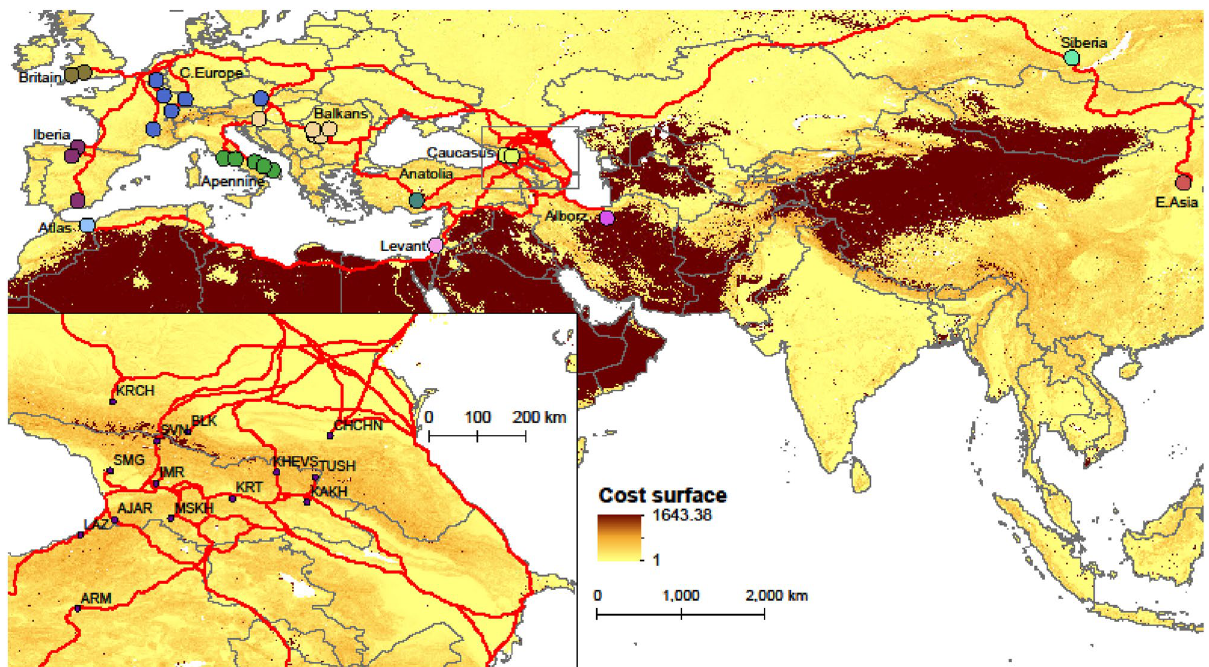
Figure 5. Migration pathways that best explain genetic affinity between modern Caucasians and ancient humans, showing least-cost paths from Eurasian and African ancient populations (shown in the main map, see Table 2 for details) to the current Caucasian populations (identified in the inset map, see Table 1 for details). The least-cost paths imply that (1) human movement is impeded by terrain ruggedness (TRI), (2) the Bosporus- Dardanelles and the English Channel do not act as barriers, (3) swamps, glaciers and desert are not full barriers, but permeable at the highest of the cost grid values, and (4) riversides in desert are permeable at TRI values. It is assumed that most human movements occurred during climate warming events when the earth’s surface was not dramatically different from that of today, and hence the current data of the geographic features are used in the calculation of the least-cost paths. The map is generated using QGIS Desktop 3.10.6-A Coruña (https:// qgis.